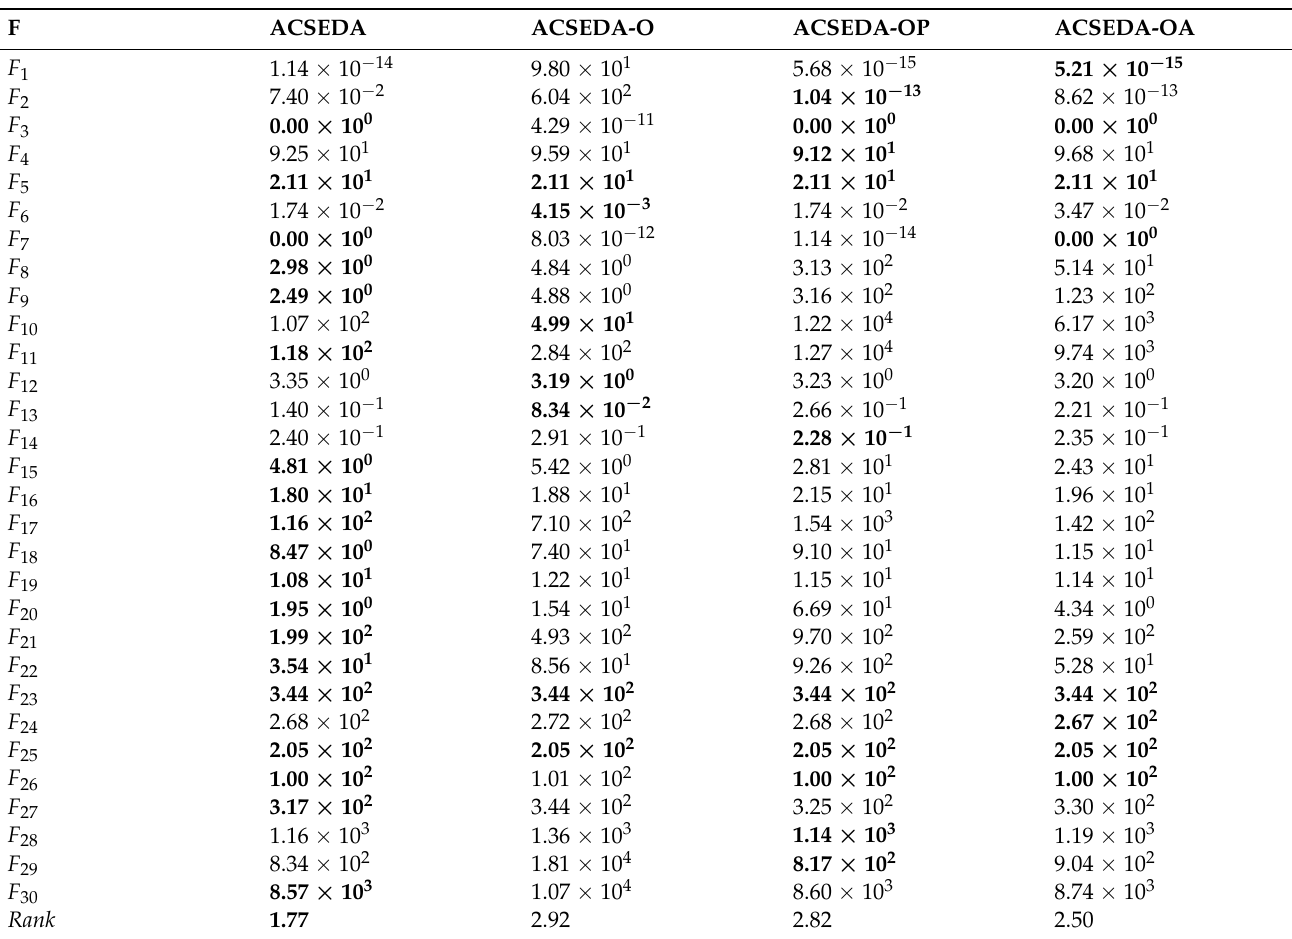
Table 8. Comparison among ACSEDA with different selection strategies for the parent population on the 50- D CEC 2014 benchmark problems. The best results are highlighted in bold in this